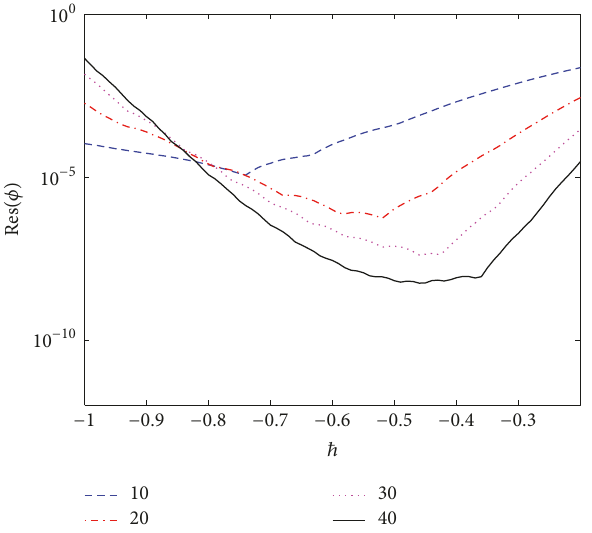
Figure 6: Residual error in 𝑔(𝜂,𝜉) against 𝜉 at different iteration levels ( 𝜆 = 1, 𝜎 = 𝛾 = 0.5, Pr = 3, Sc = 2, ℏ = −0.5 ).